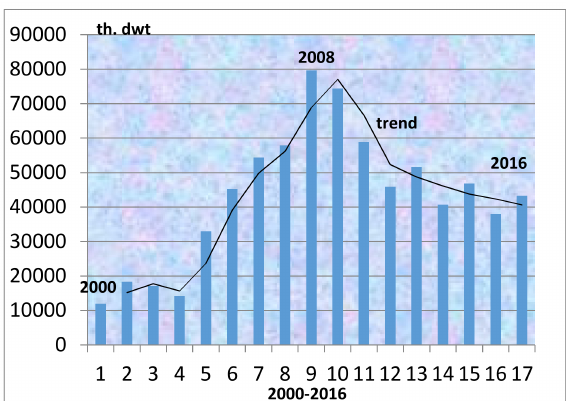
Figure 2. Containerships on order, 2000–2016 (000 dwt). Source: Author and excel on numbers from UNCTAD